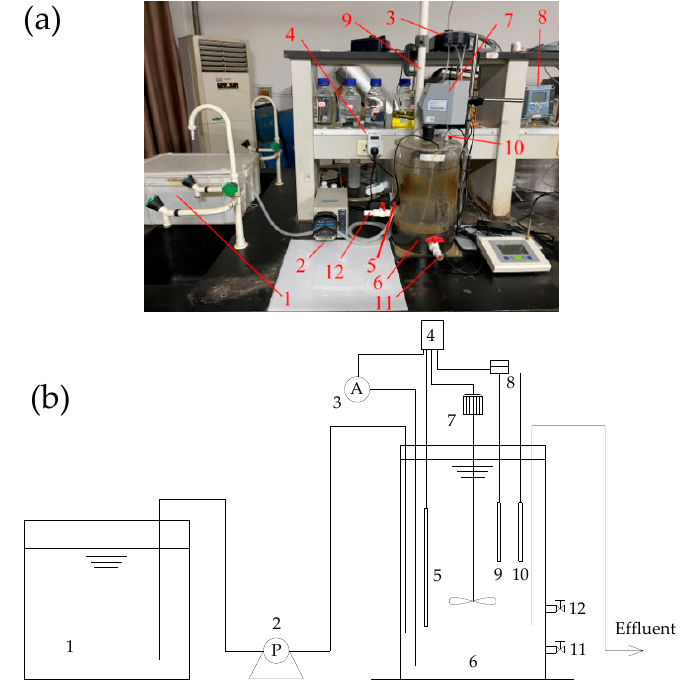
Figure 1. The schematic diagram ( a ) and the photo ( b ) of the sequencing batch reactor (SBR).